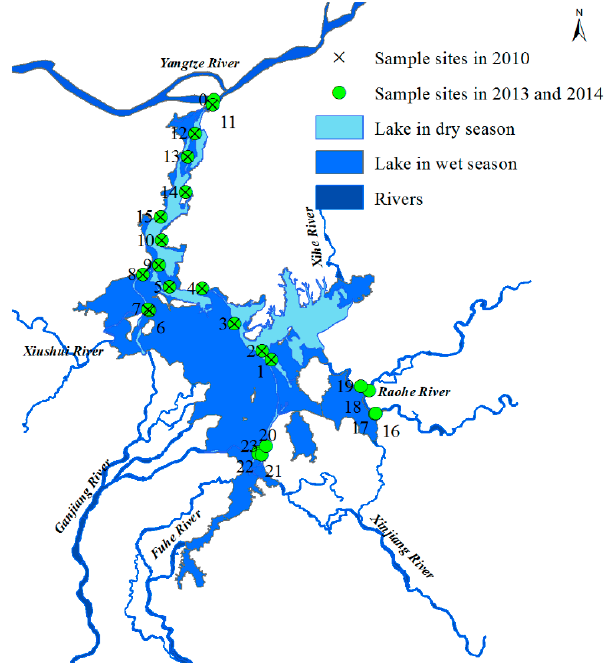
Figure 1. Locations of sample sites in Lake Poyang, China.